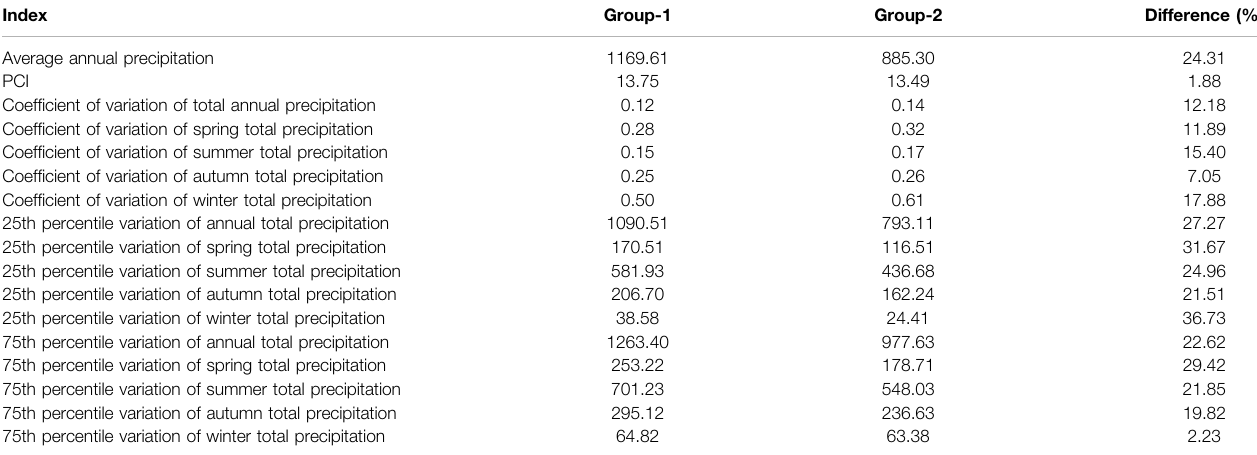
TABLE 5 | Difference in precipitation index between two precipitation regions.